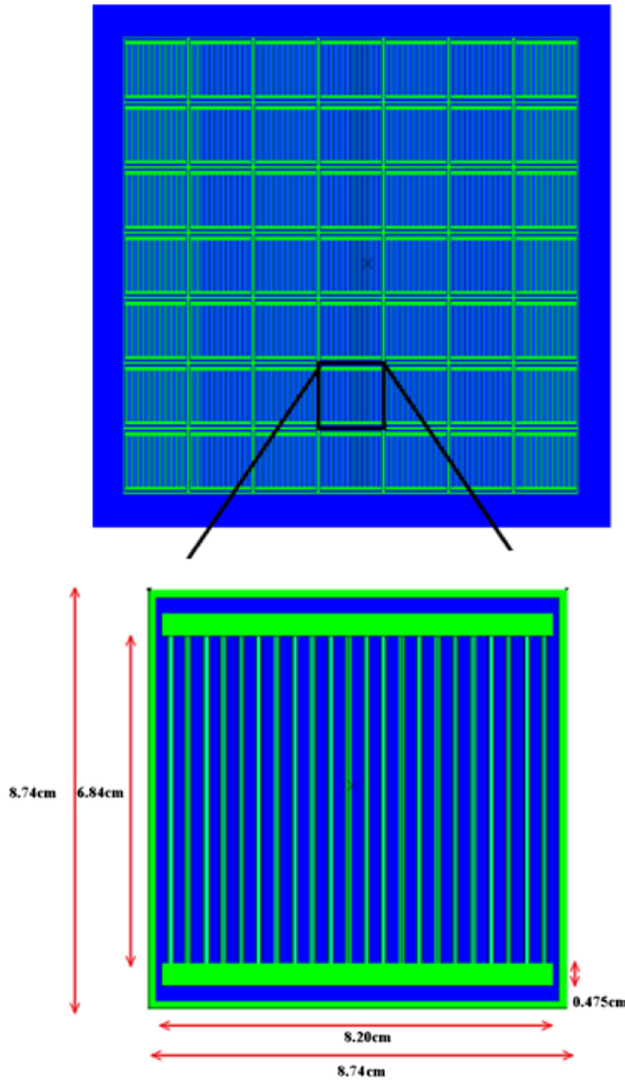
Fig. 2. Geometric representation of the